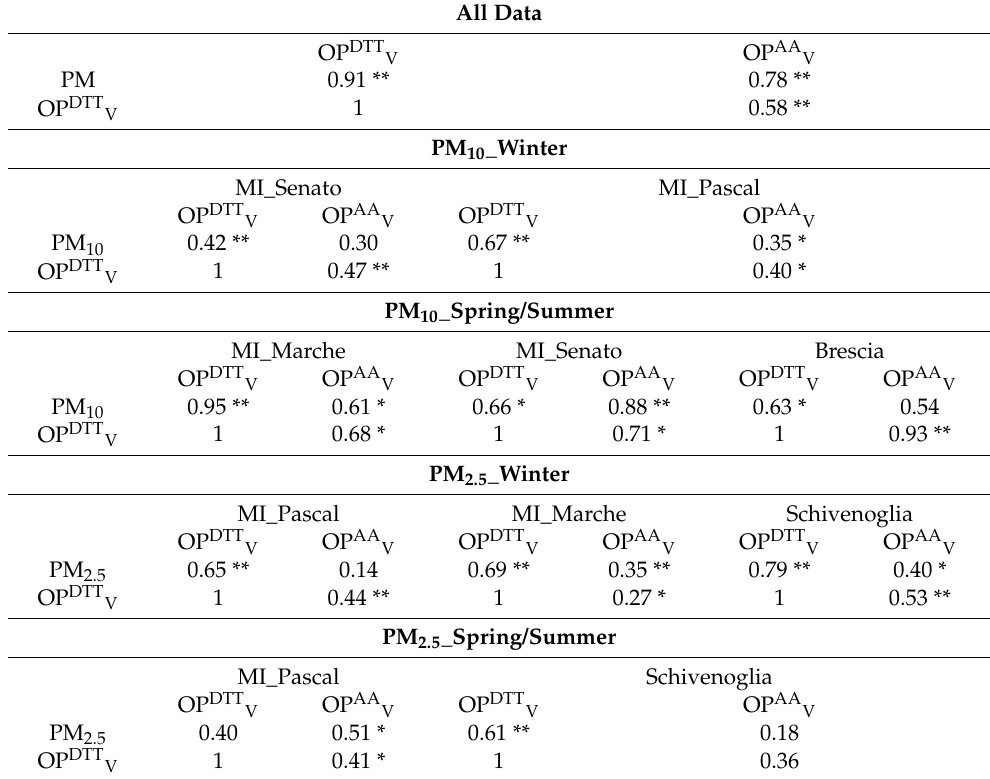
Table 3. Dependence of PM oxidative properties on the PM mass concentration and the type of the OP assay: Pearson’s correlation coefficients ( r ) between the OP V responses and the PM mass concentration and between the OP DTT V and OP AA V responses. Cumulative results on all the study data and results by investigating each sampling campaign, separately. Units: PM ( µ g m − 3 ); OP V (nmol min − 1 m − 3 ). All Data OP DTT V OP AA V 0.91